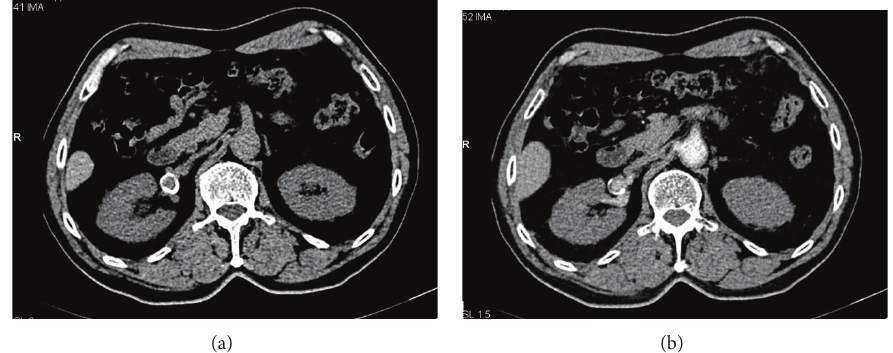
Figure 3: Precontrast (a) and postcontrast (b) axial MDCT images. We can see that the ring-like calcification represented an aneurysm of the right renal artery which had a diameter of 1.8 cm and was saccular in shape.